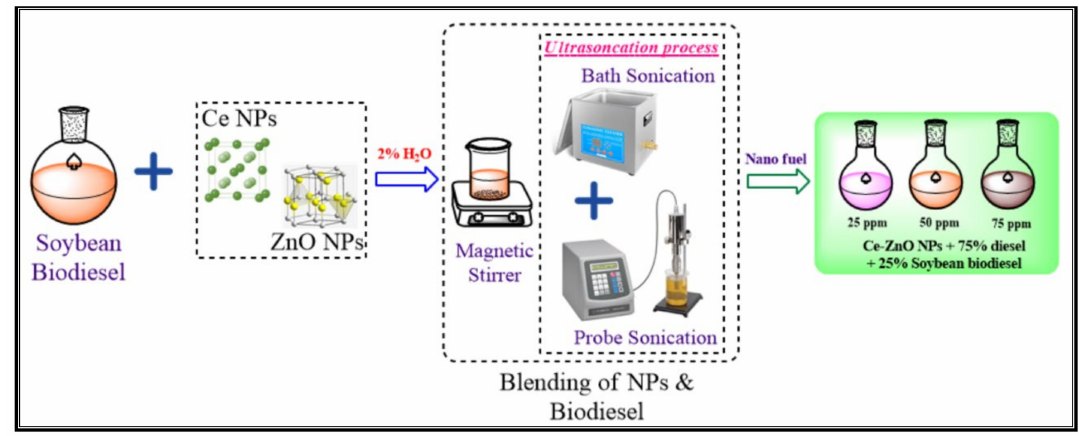
Figure 4. Preparation of nano fuel blends using